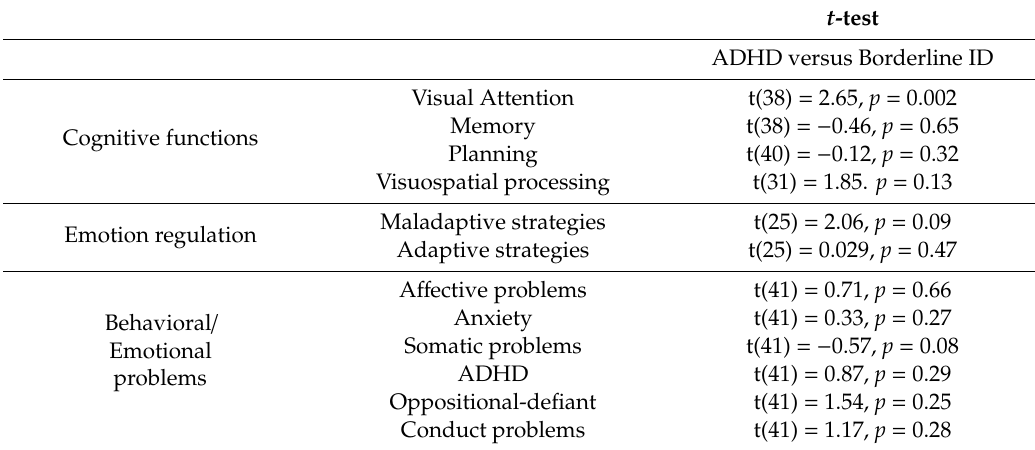
Table 3. Di ff erences between children with ADHD and children with borderline